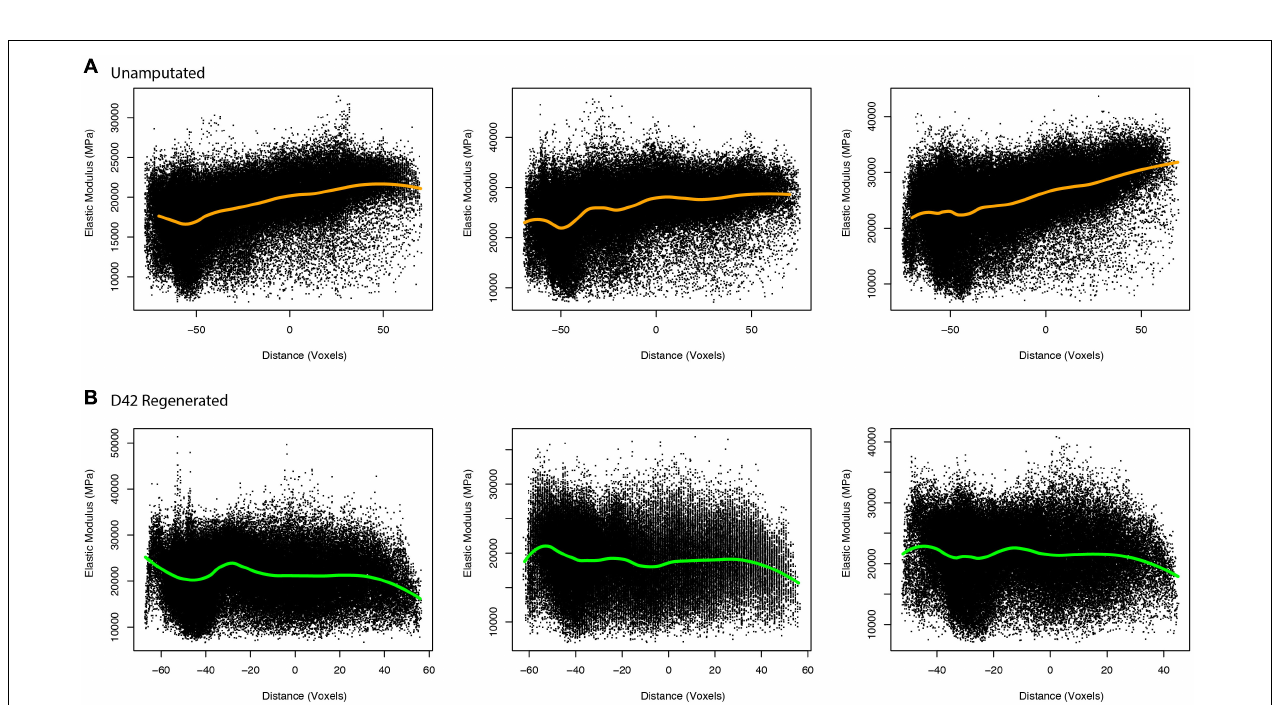
FIGURE 4 | Elasticity in unamputated and regenerated aged bone. Proximal/distal plotting of numerically calculated (A) unamputated and (B) regenerated (D42) elastic modulus values of individual digits ( N = 3 per group). The local polynomial regression curve indicated in green indicates the spatial trend in modulus value.